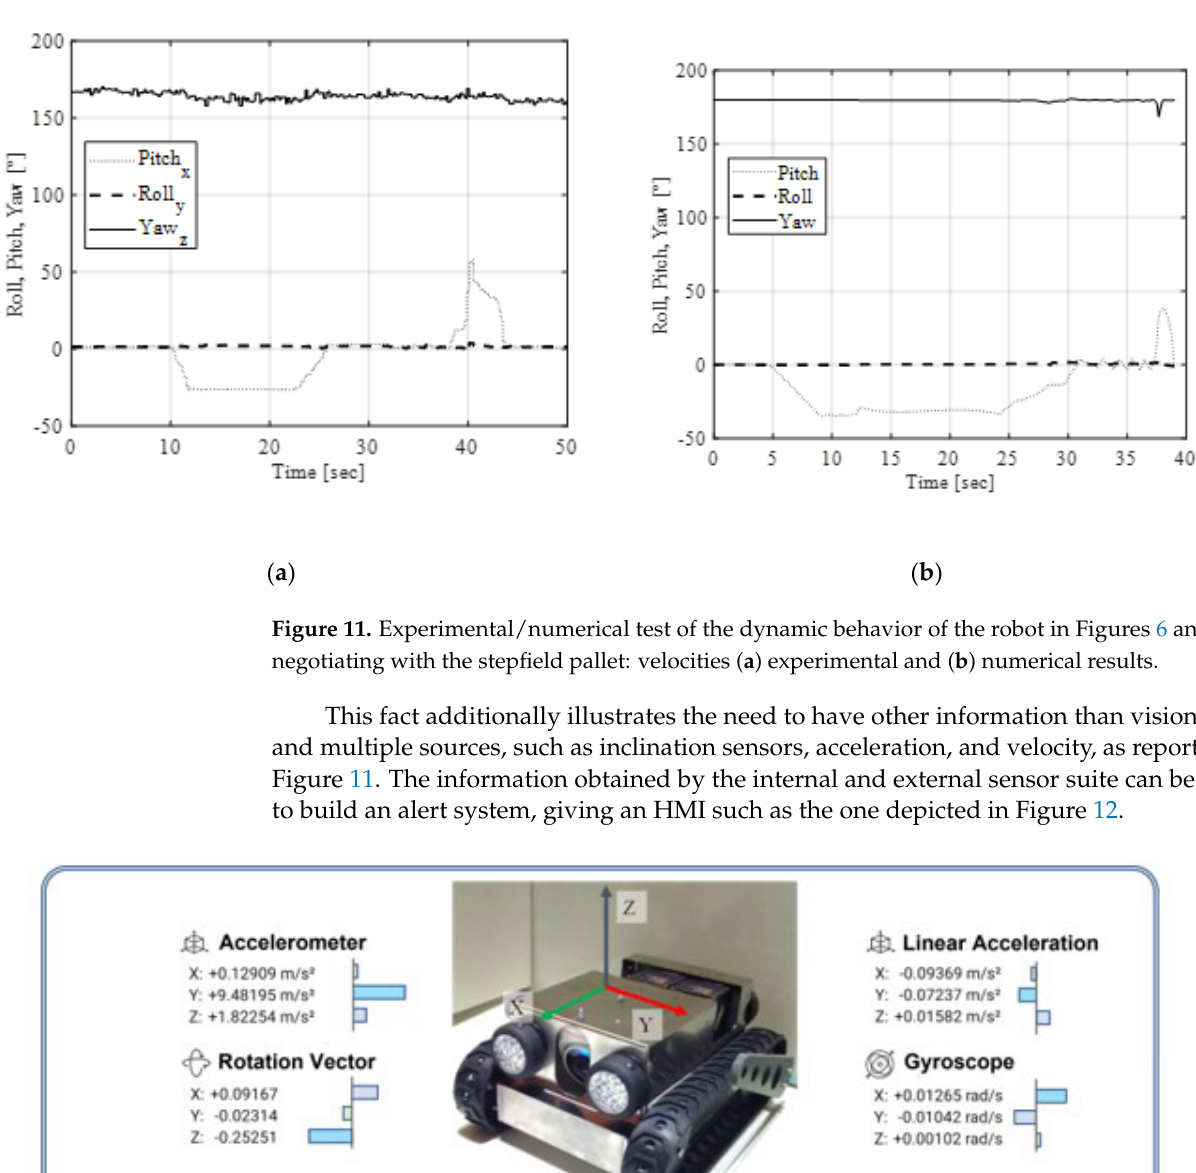
Figure 12. HMI for the visualization of the internal sensor suite.